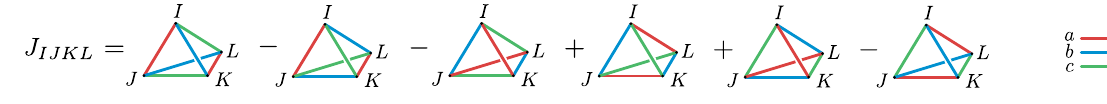
FIG. 1. Pictorial representation of the antisymmetric tensor J